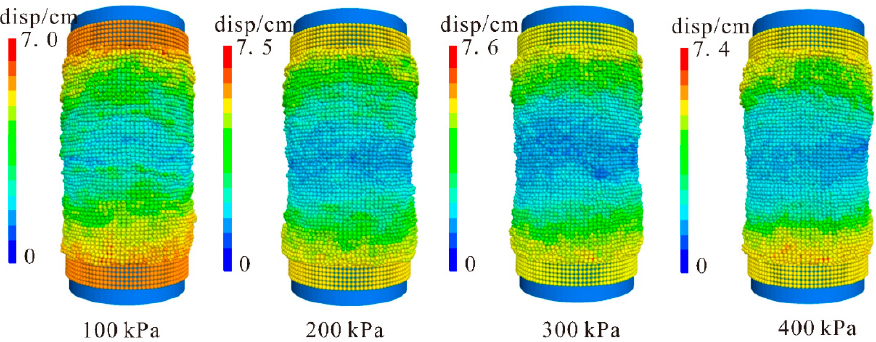
Figure 6. Loading results of undisturbed soils.